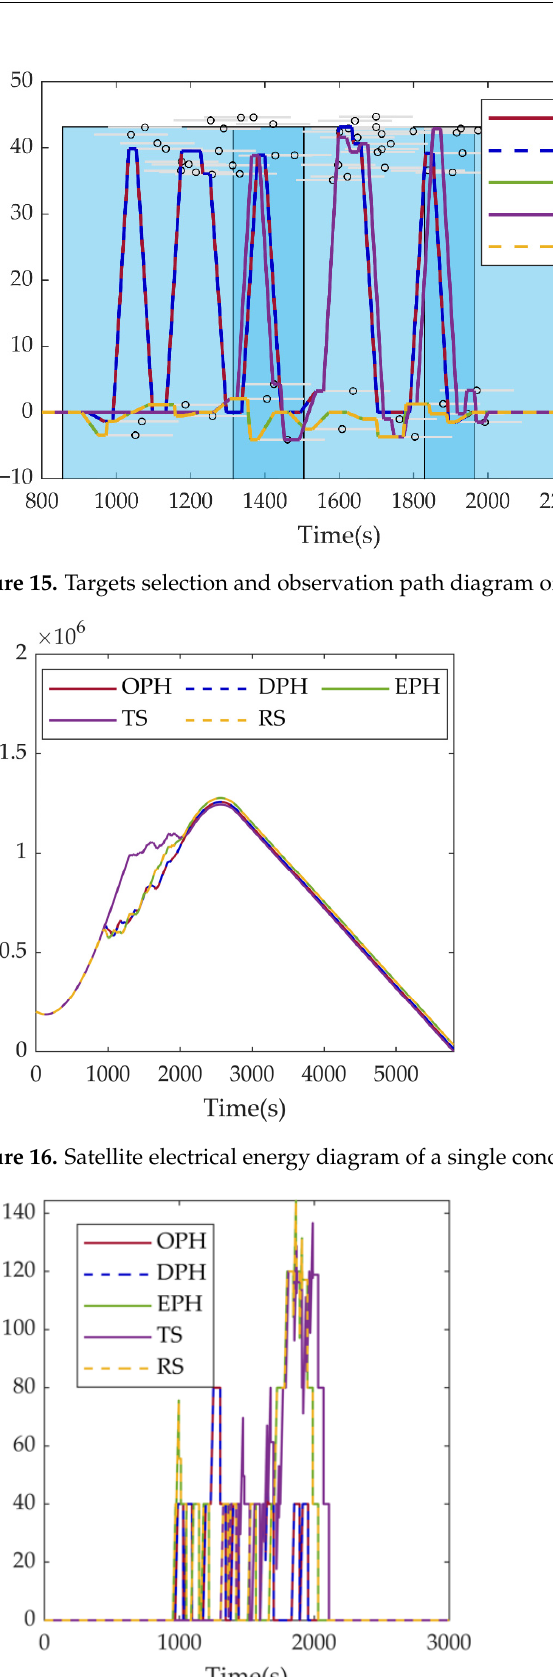
Figure 18. Charging electrical power chart of a single condition in the third group. 5. Discussion By comparing the objective function value J for all methods mentioned in the previ- ous section, OPH had better results under the conditions of having enough data transmis- sion time, memory capacity, and electrical energy, but had poorer performance when there was a lack of data transmission time and electrical energy; the ratios of the resulting values of OPH to TS in the three groups of conditions (the conditions are mentioned in Table 3) were 96%, 88%, and 74%, respectively. DPH worked better when it had a lack of data transmission time, but worse with the other two groups of conditions as the ratios of the resulting J values to TS in the three groups of conditions were 88%, 98%, and 74%, respectively. Additionally, EPH had a more favorable performance when electrical energy was deficient, but not in the other two groups of conditions, as the proportions of its re- sulting J values to TS were 74%, 80%, and 92%, respectively. In contrast, RS outperformed the other three methods as its ratios of the resulted objective function value J to those of TS were 96%, 98%, and 92%, respectively, under the three groups of conditions. In short, RS worked well under all different conditions, whereas the heuristic methods only per- formed better under suitable conditions. Under appropriate conditions, the heuristic methods and RS performed similarly, as the ratio of their resulting J value to TS was about 96%. However, with unsuitable conditions, the results of RS were roughly 16% higher